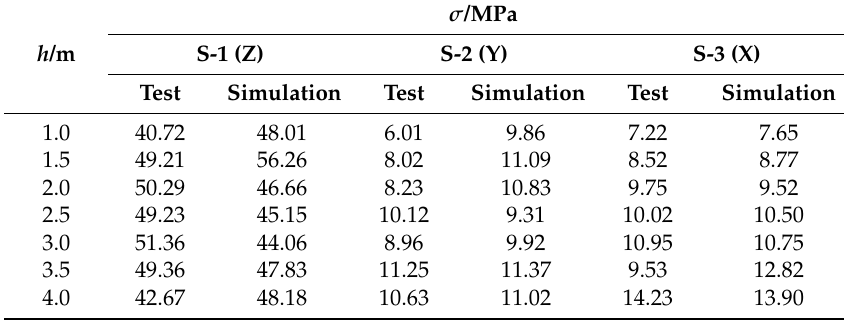
Table 3. The maximum level of stress of the piezoelectric sensor under different impacts.